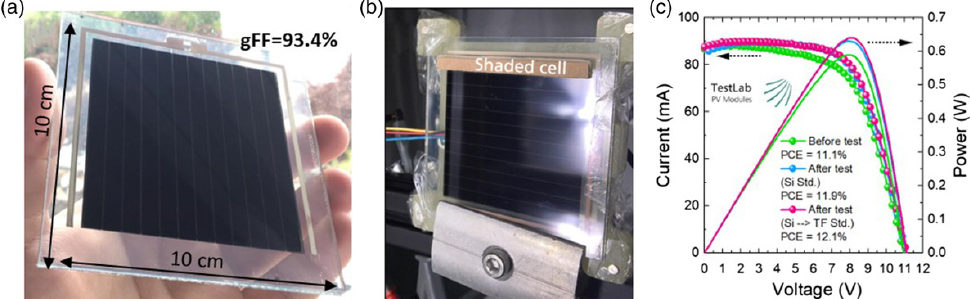
Figure 30. ( a ) Photograph of an encapsulated perovskite solar module with carbon-based contact (C-PSM). ( b ) Photograph of the module with one fully shaded cell during the hotspot test. ( c ) I–V and P–V curves of the module before (green) and after conducting test according to silicon ageing test (blue), followed by conducting an additional thin-film ageing test (cerise) on the same module, showing no loss of performance after both IEC-compliant tests [106]. (Reprinted with permission from Ref. [106], 10.1002/solr.202100527, under the terms of the CC BY [3.0] license Copyright © 2022Wiley-VCH GmbH).